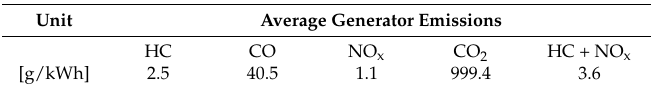
Table 4. Emission factors for the generator ReX trailer